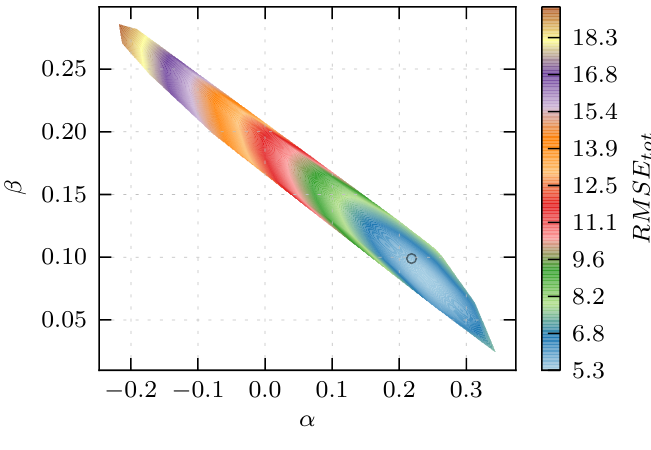
1 for Figure 6. RMSE (root-mean-square error with respect to experiment) in kJ mol − tot all 17 predicted binding free energies, as a function of model α and β parameters. The data in this figure have been generated by permuting over all possible combinations of training sets of size 9 out of the total number of ligands (17), and by optimizing the LIE α and β parameters for each permutation. The center of the circle refers to the model in the 1 middle-right panel of Figure 3, for which RMSE = 5 . 5 kJ mol − tot